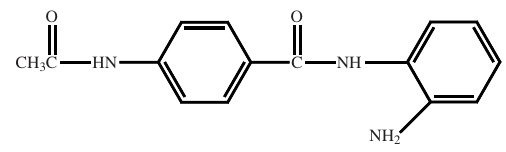
Figure 1: Chemical structure of